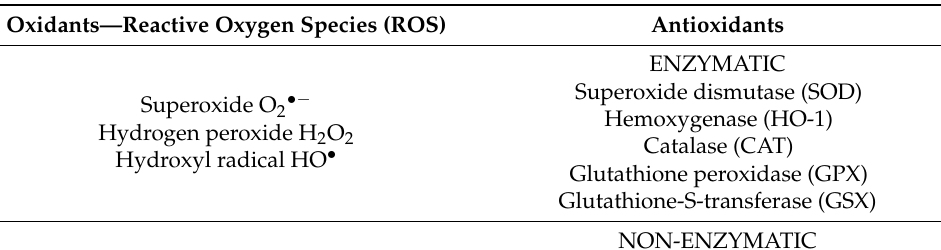
Table 1. The most relevant oxidants and antioxidants involved in oxidative stress during PE